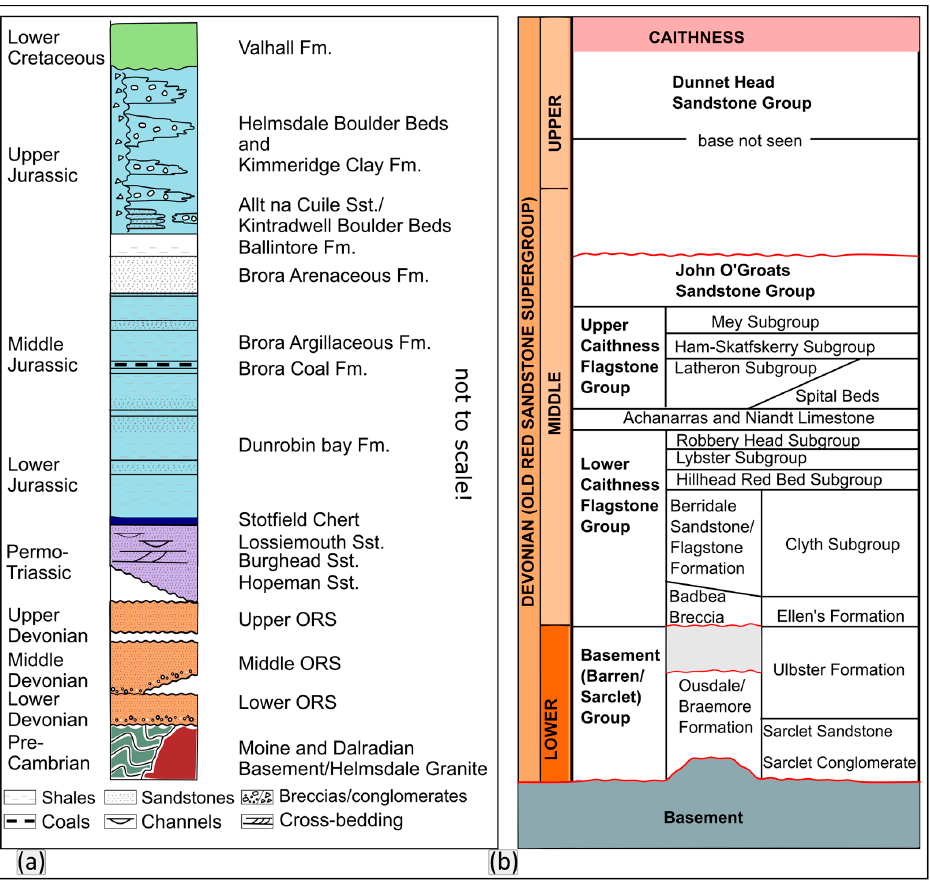
Figure 2. ( a ) Summary of onshore stratigraphy (modified after [18]). Not to scale, with relative thicknesses shown in a notional fashion. ORS—Old Red Sandstone. ( b ) Simplified stratigraphy of the Lower to Upper Devonian from Caithness (compiled after [10,15,19]).